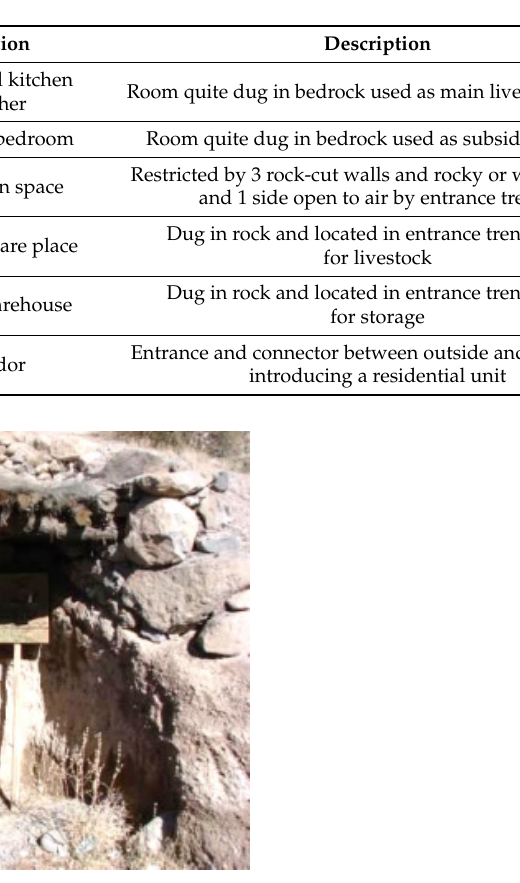
Table 3. The description of the function of rooms in Maymand’s house architecture according to Figure 23.